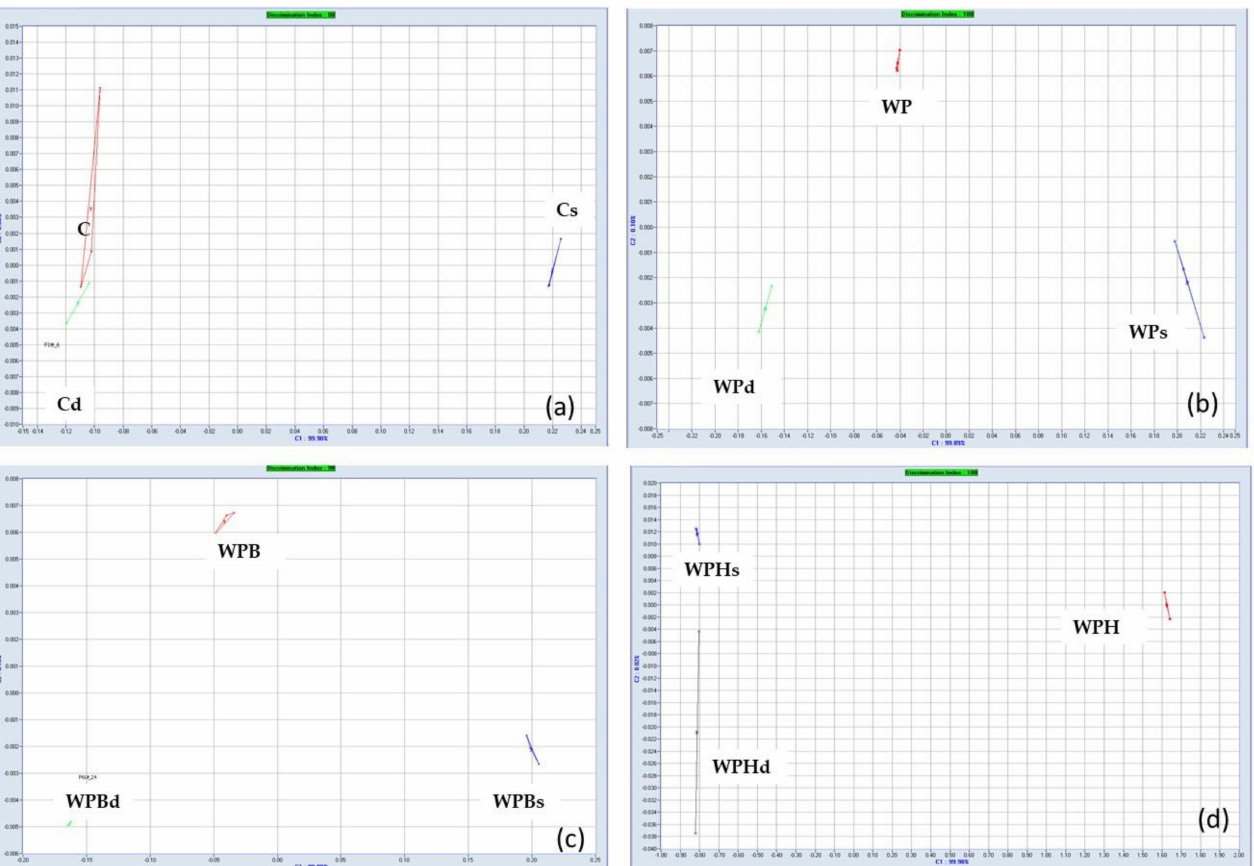
Figure 4. Principal component analysis (PCA) plot for the bread samples. ( a ) Discrimination of samples C, Cs, Cd; ( b ) Discrimination of samples WP, WPs, WPd; ( c ) Discrimination of samples WPB, WPBs, WPBd; ( d ) Discrimination of samples WPH, WPHs,